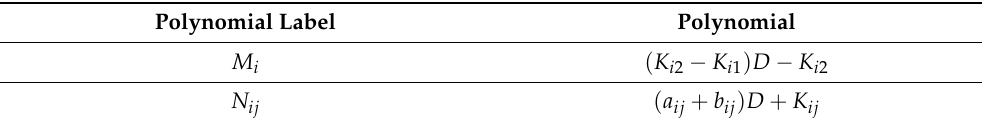
Table 2. Polynomial label. Polynomial